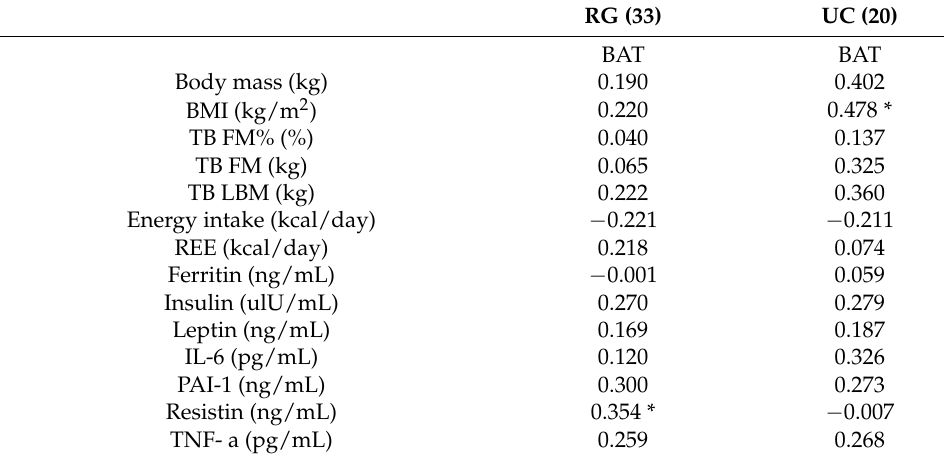
Table 4. Spearman correlation coefficients between BAT and different body composition